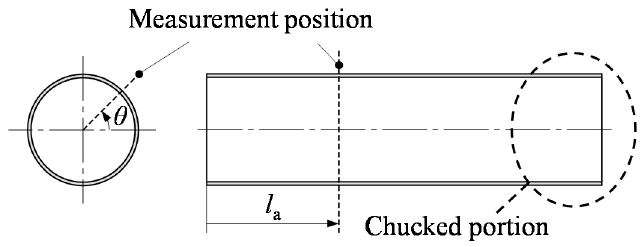
Figure 8. Measurement position of thickness t in drawn tube. Table 3. Process conditions for the expansion and plug drawing processes.